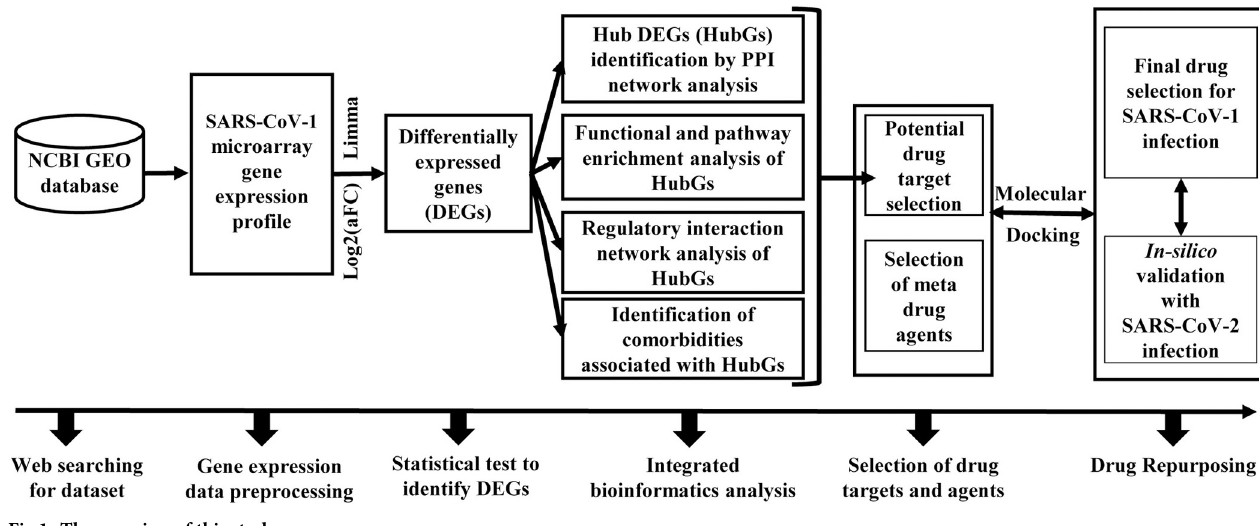
Fig 1. The overview of this